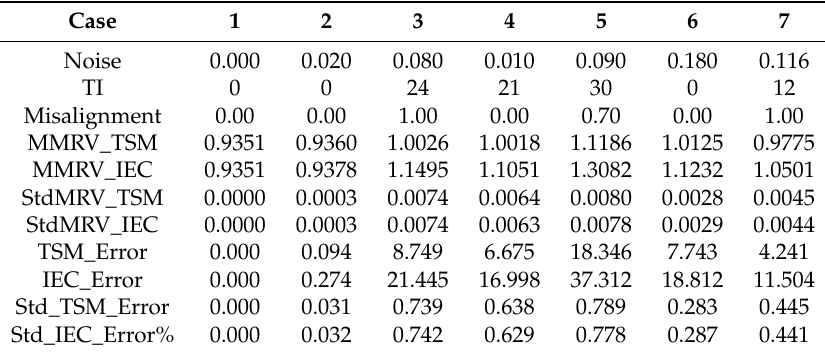
Table A1. Subset of the synthetic